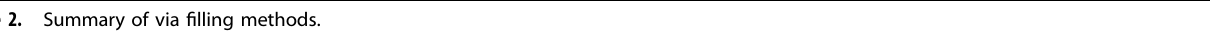
Table 2. Summary of via fi lling methods. Number of processing steps Via fi lling